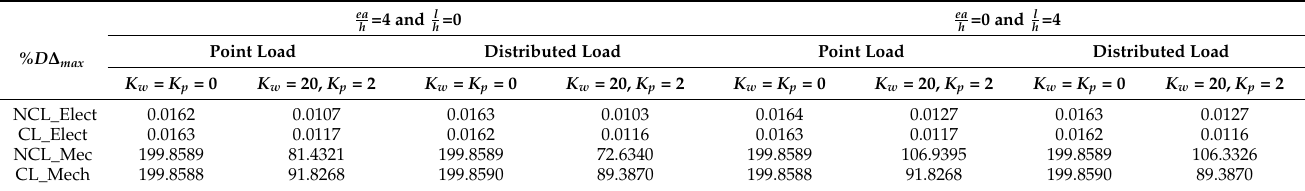
Table 5. The relative percentage difference in the transverse deflection ( % D ∆ max ) ing the perforation filling ratio α for electromechanical and mechanical nonclassical and classical behaviors for different values of the nondimensional elastic foundation and nonclassical parameters under point and uniformly distributed loads at perforation filling ratio, α = 0.2 and 0.5, at N = 4 and beam aspect ratio L / h = 20, e 311 = − 4.1 C/m 2 , µ 3111 = 5 × 10 − 8 C/m, a 33 = 7.124 × 10 − 9 C/m 2 K, and α = 0.2 to